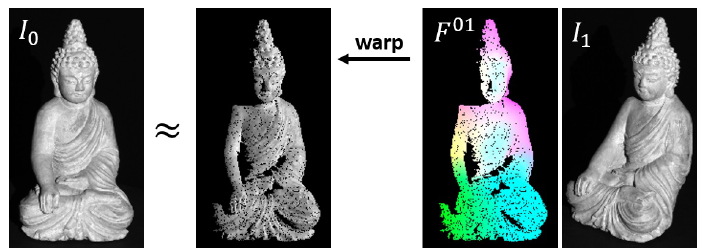
Figure 3. Image I 0 in comparison to image I 1 that has been warped by optical flow F 01 . Assuming consistent brightness, these should be identical (ignoring masked pixels due to the semi-dense optical flow from real data). In case of strong rotations of the object, the shading changes dramatically, which violates this